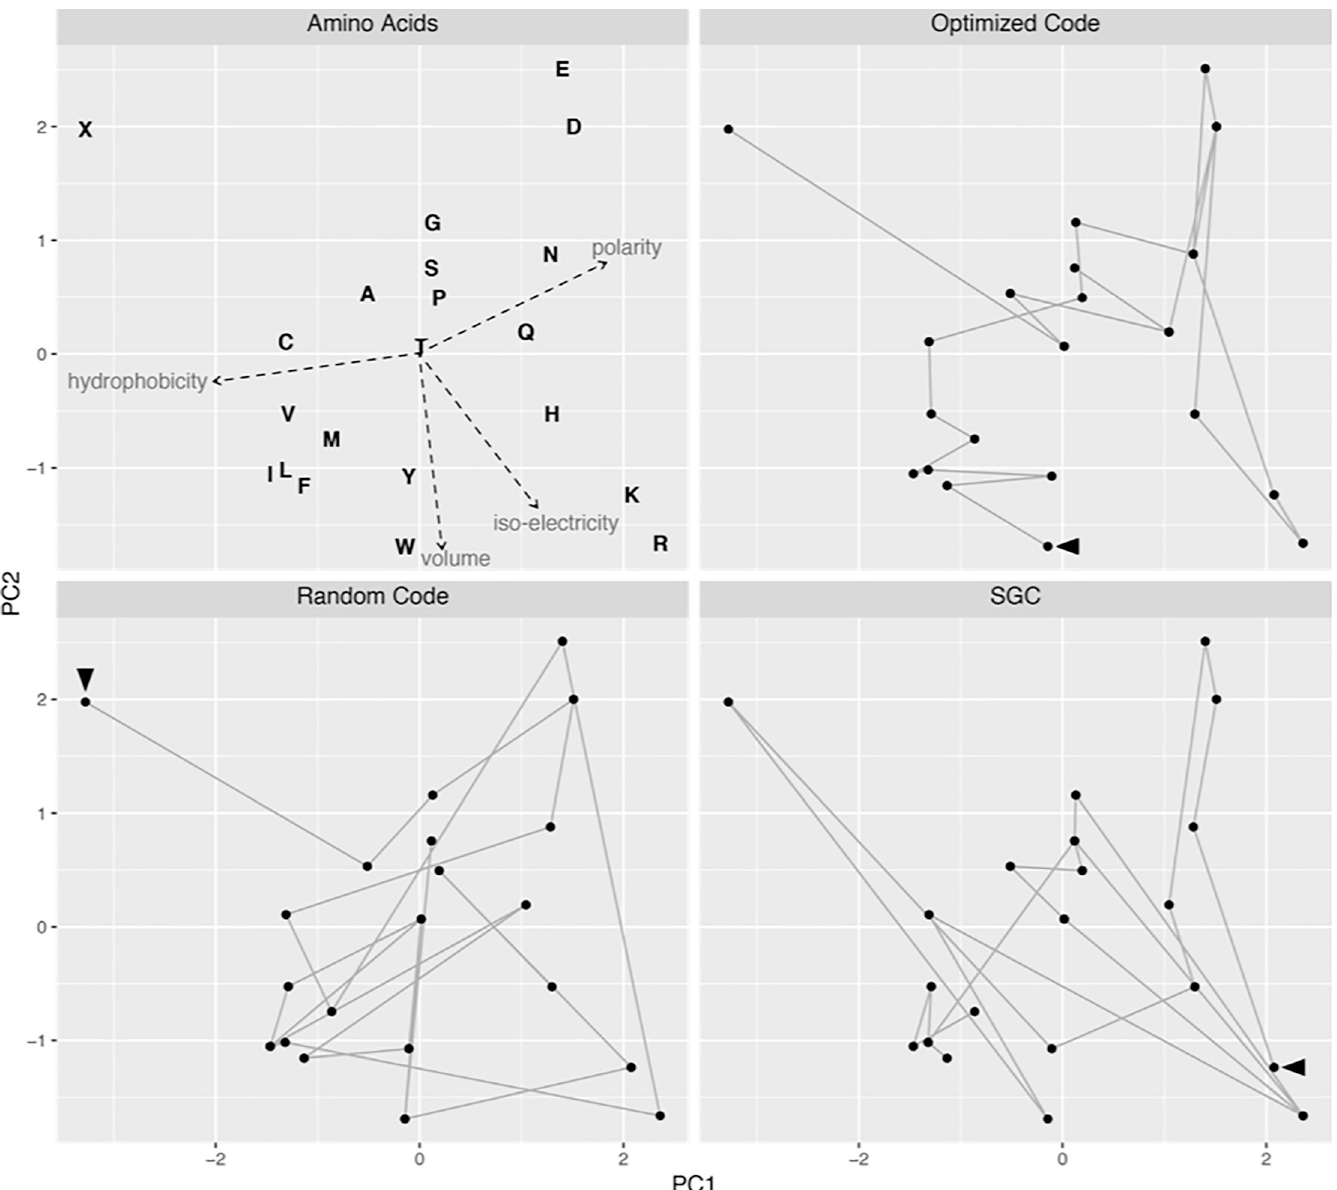
Fig 3. Hopfield network minimizes amino acid tour lengths. ( Top left ) First two principal components of the four amino acid indices (Table 1). The variances explained by the 1 st and 2 nd principal components are 48.73% and 37.96% respectively. ( Top right ) Amino acid path of a Hopfield-simulated code optimized for polarity and volume (tour lengths 32.2 ± 4.4 in polarity error). ( Bottom left ) Amino acid path of a randomly permuted code (tour lengths 56.3 ± 4.6, sample size 1000). ( Bottom right ) Amino acid path of SGC (tour length 41.0).